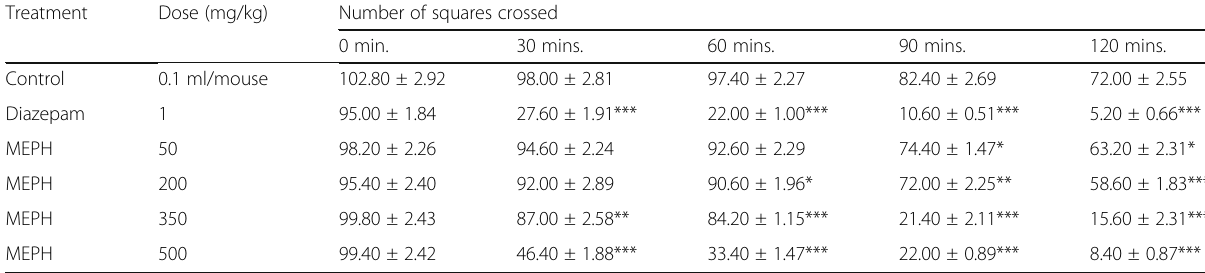
Table 2 The effect of MEPH on the open field test in mice Treatment Dose (mg/kg) Number of squares crossed